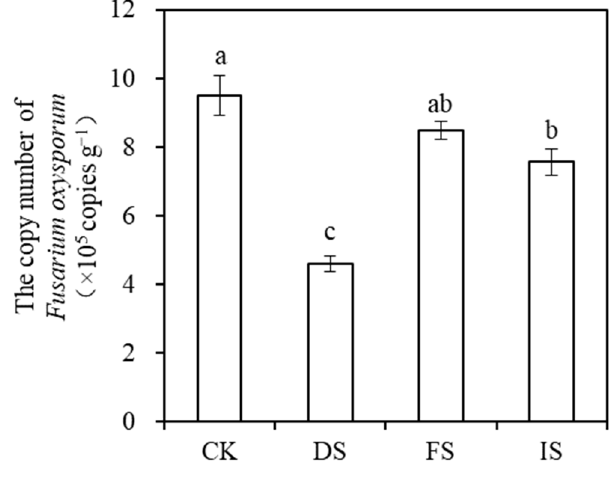
Figure 7. The gene copy number of F. oxysporum in the soil of different treatments. CK: replanted soil, DS: air-dried T . erecta sample, FS: fresh T . erecta sample, IS: infusion solution of fresh T . erecta .